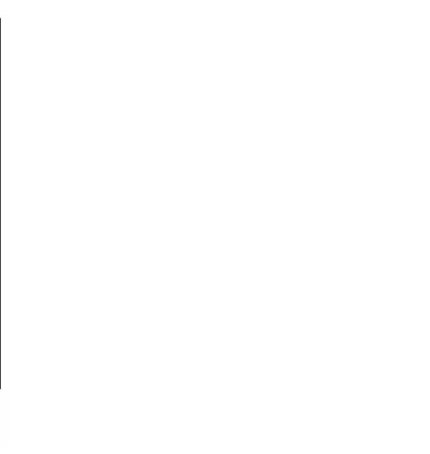
Figure 15. Admittance curves of modified 1-3 type composites with different silicone rubber widths.